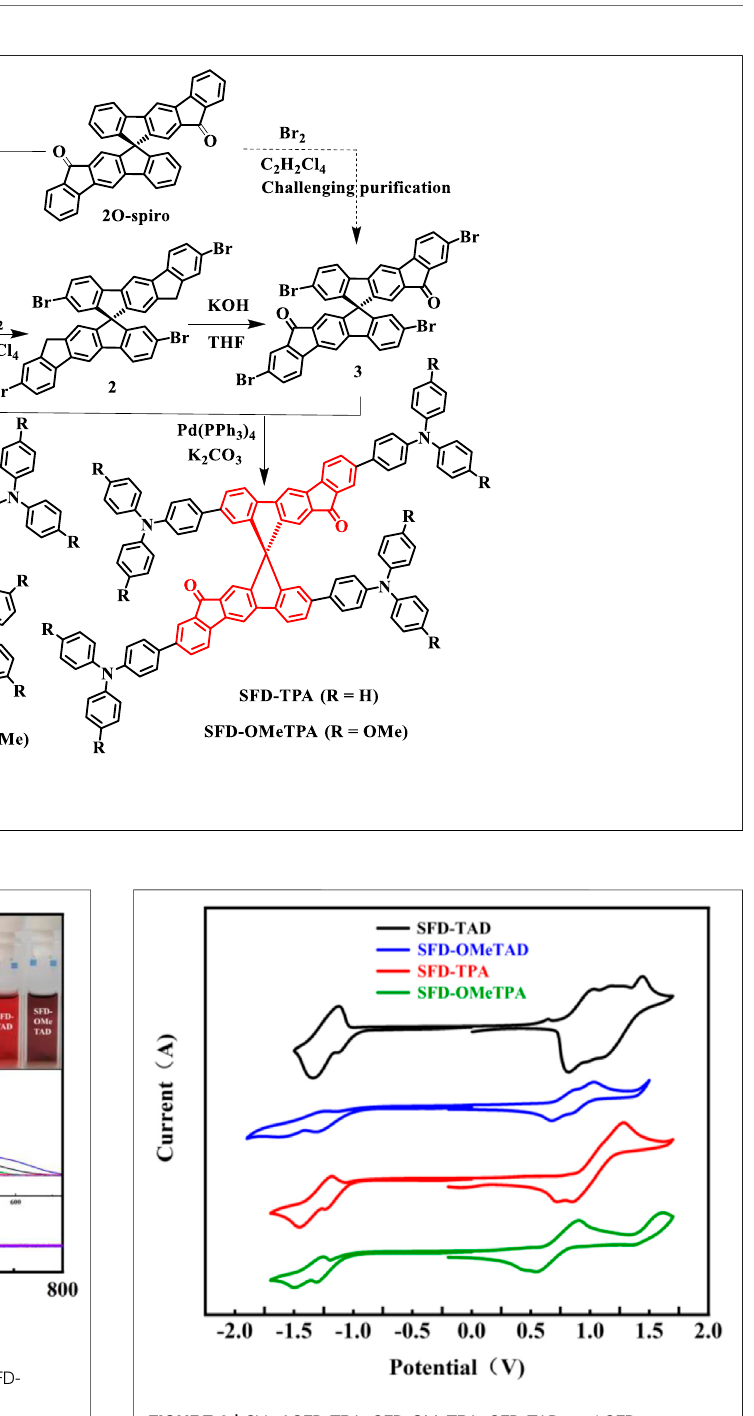
FIGURE 3 | CV of SFD-TPA, SFD-OMeTPA, SFD-TAD, and SFD-